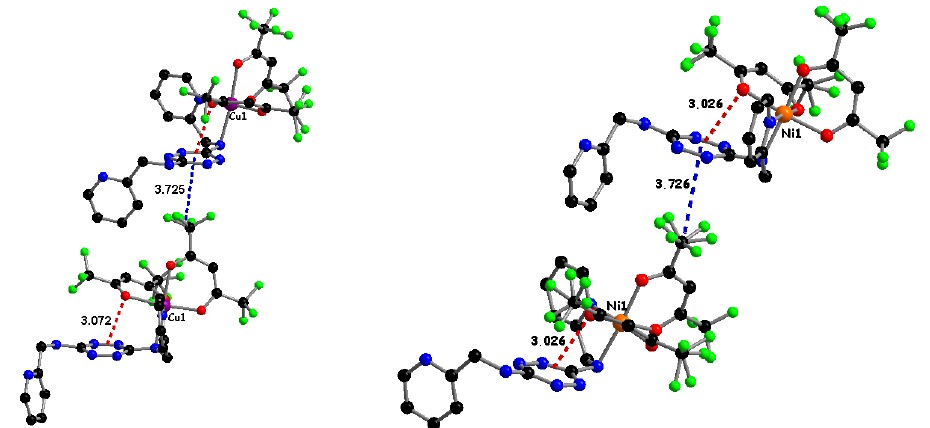
Figure 2. Anion– π interactions between TTZ and fluorine atoms (blue lines), and TTZ and oxygen atoms (red line) in 1 ( left ) and 2 ( right ). Hydrogen atoms were omitted for clarity.